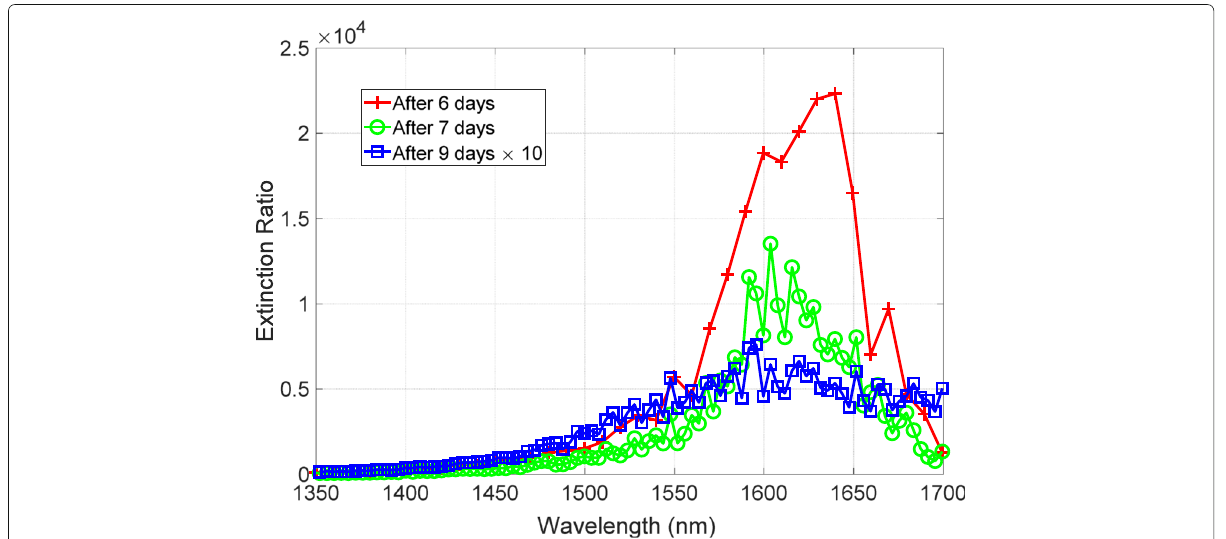
Fig. 7 Time degradation of the extinction ratio. The red, green, and blue lines are the extinction ratio spectra for 6, 7, and 9 days after the metal deposition